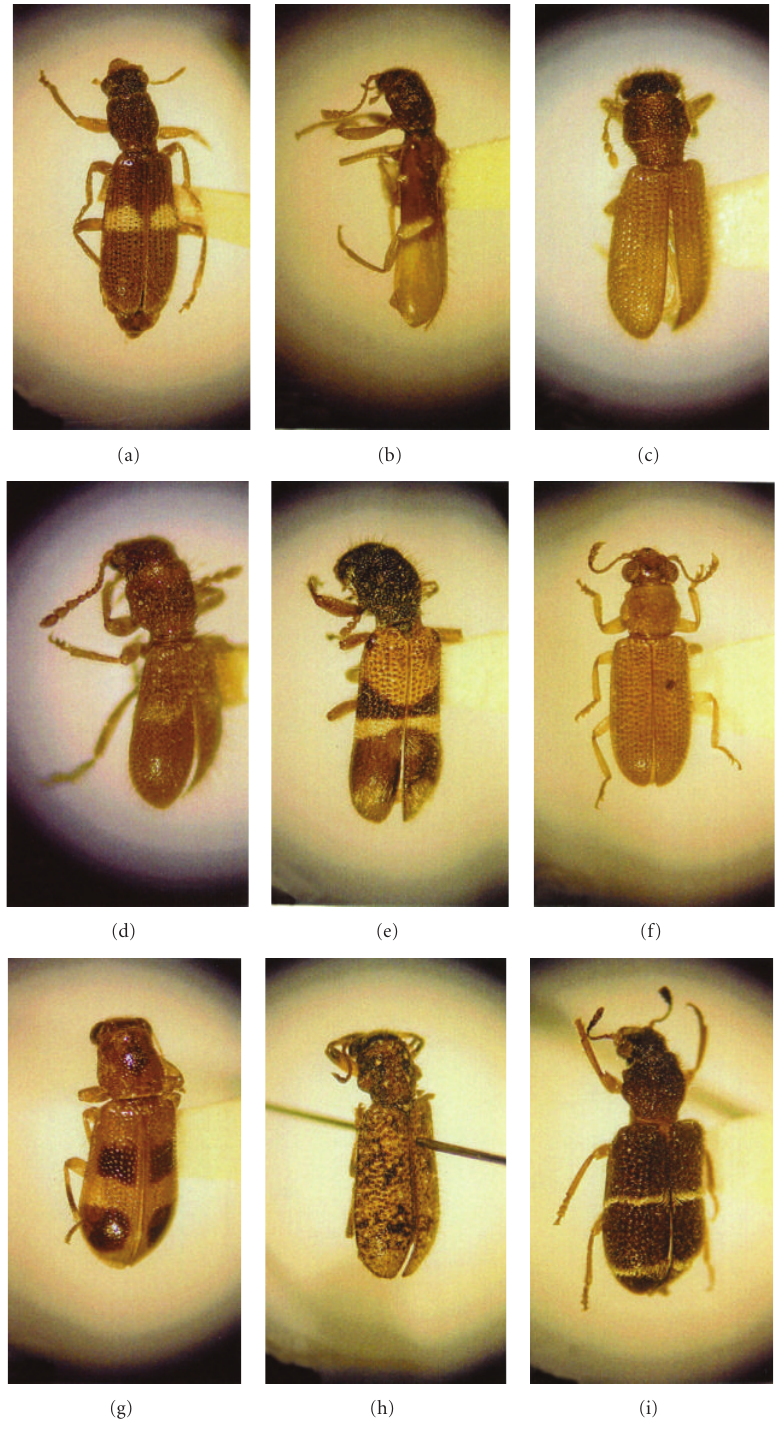
Figure 22: Habitus. (a) Abiliella fasciata . (b) Agapetilus vietus . (c) Apopylus unumgarensis . (d) Apteropilo pictipes . (e) Blackburniella intricata . (f) Fallopylus pallipes . (g) Globoclava quadrimaculata . (h) Neopylus nahuelbutensis . (i) Parapylus bicinctus